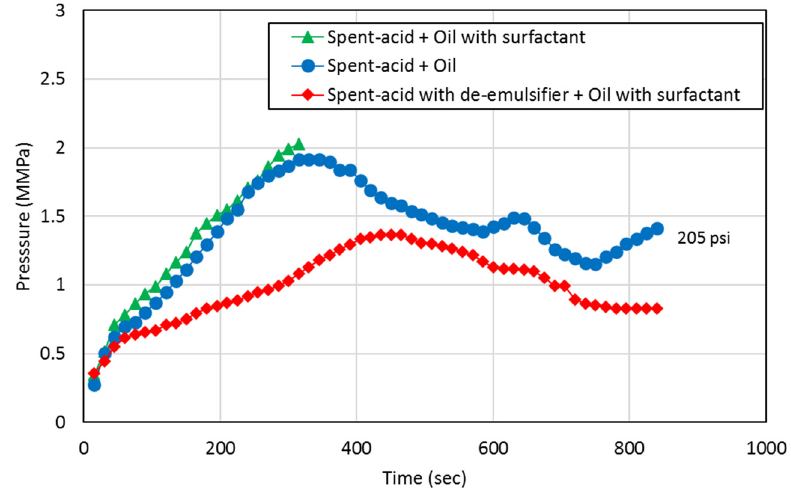
Figure 7. Pressure responses when spent-acid was injected for the three scenarios.